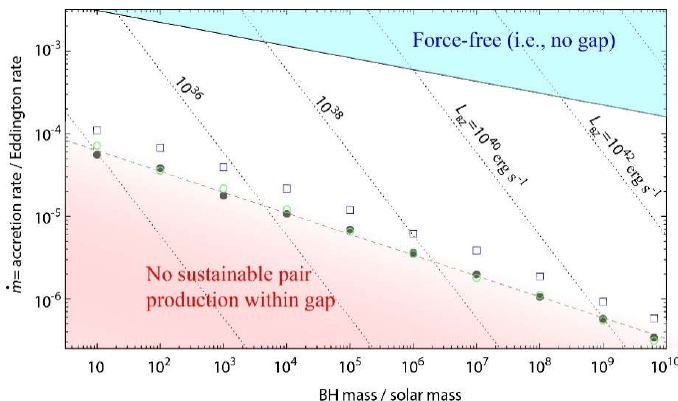
·  m ). ). The ·  m , above which the , above which the